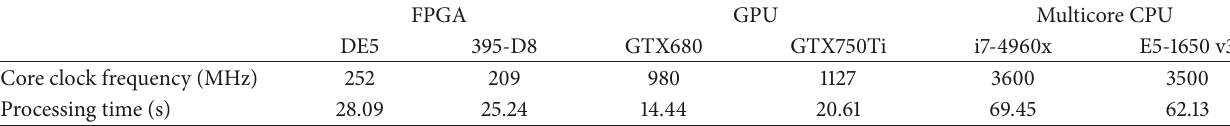
Table 3: Comparison with GPUs and CPUs using double-precision floating-point computation.